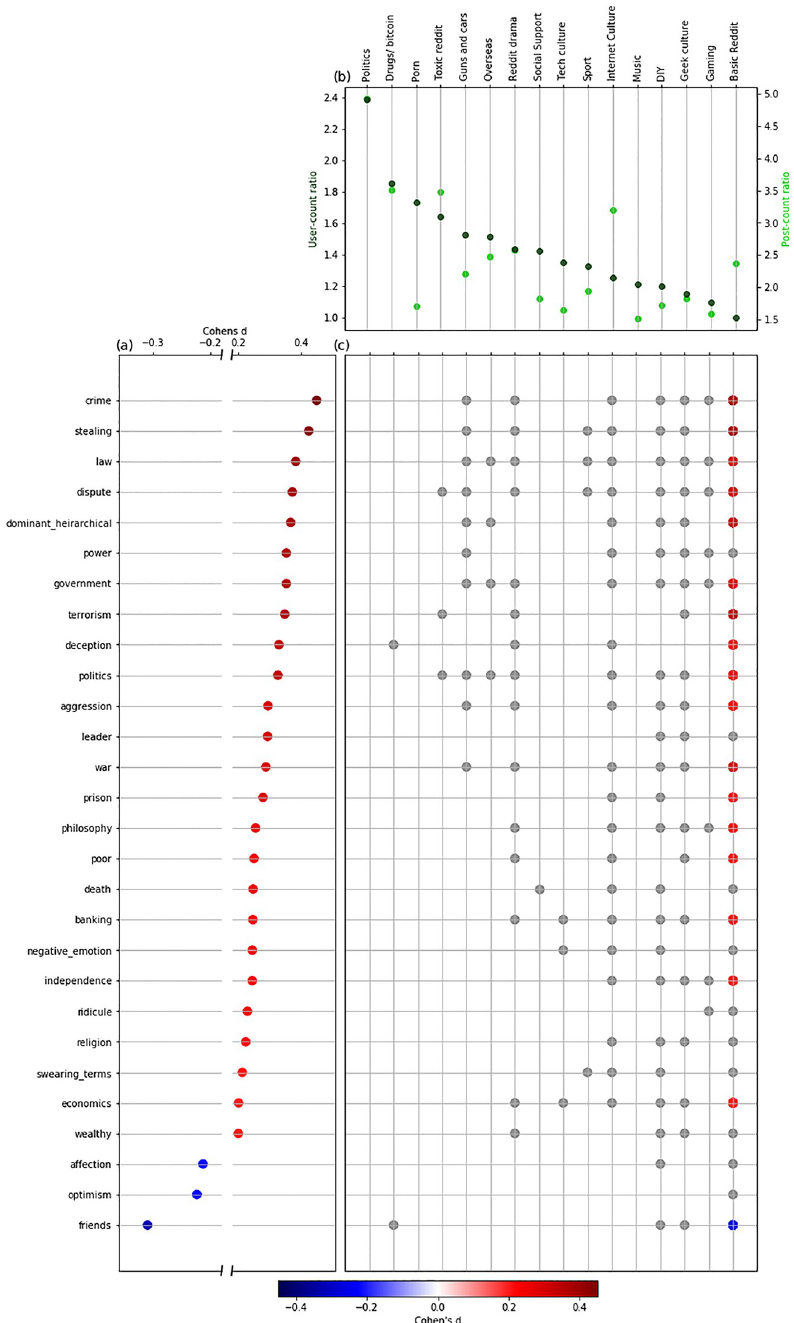
Fig 1. Differences between the r/conspiracy group and the matched controls. Differences between the r/conspiracy group and the matched control group by: (a) language use, including all Empath categories with significant positive (red) and negative (blue) differences and Cohen’s d > 0.2; (b) posting differences by theme community given by user- count ratio and post-count ratio; and (c) differences in language use accounting for theme community. Positive (red) and negative (blue) differences are colored where Cohen’s d > 0.2. Grey circles indicate significance which did not reach the effect size threshold.